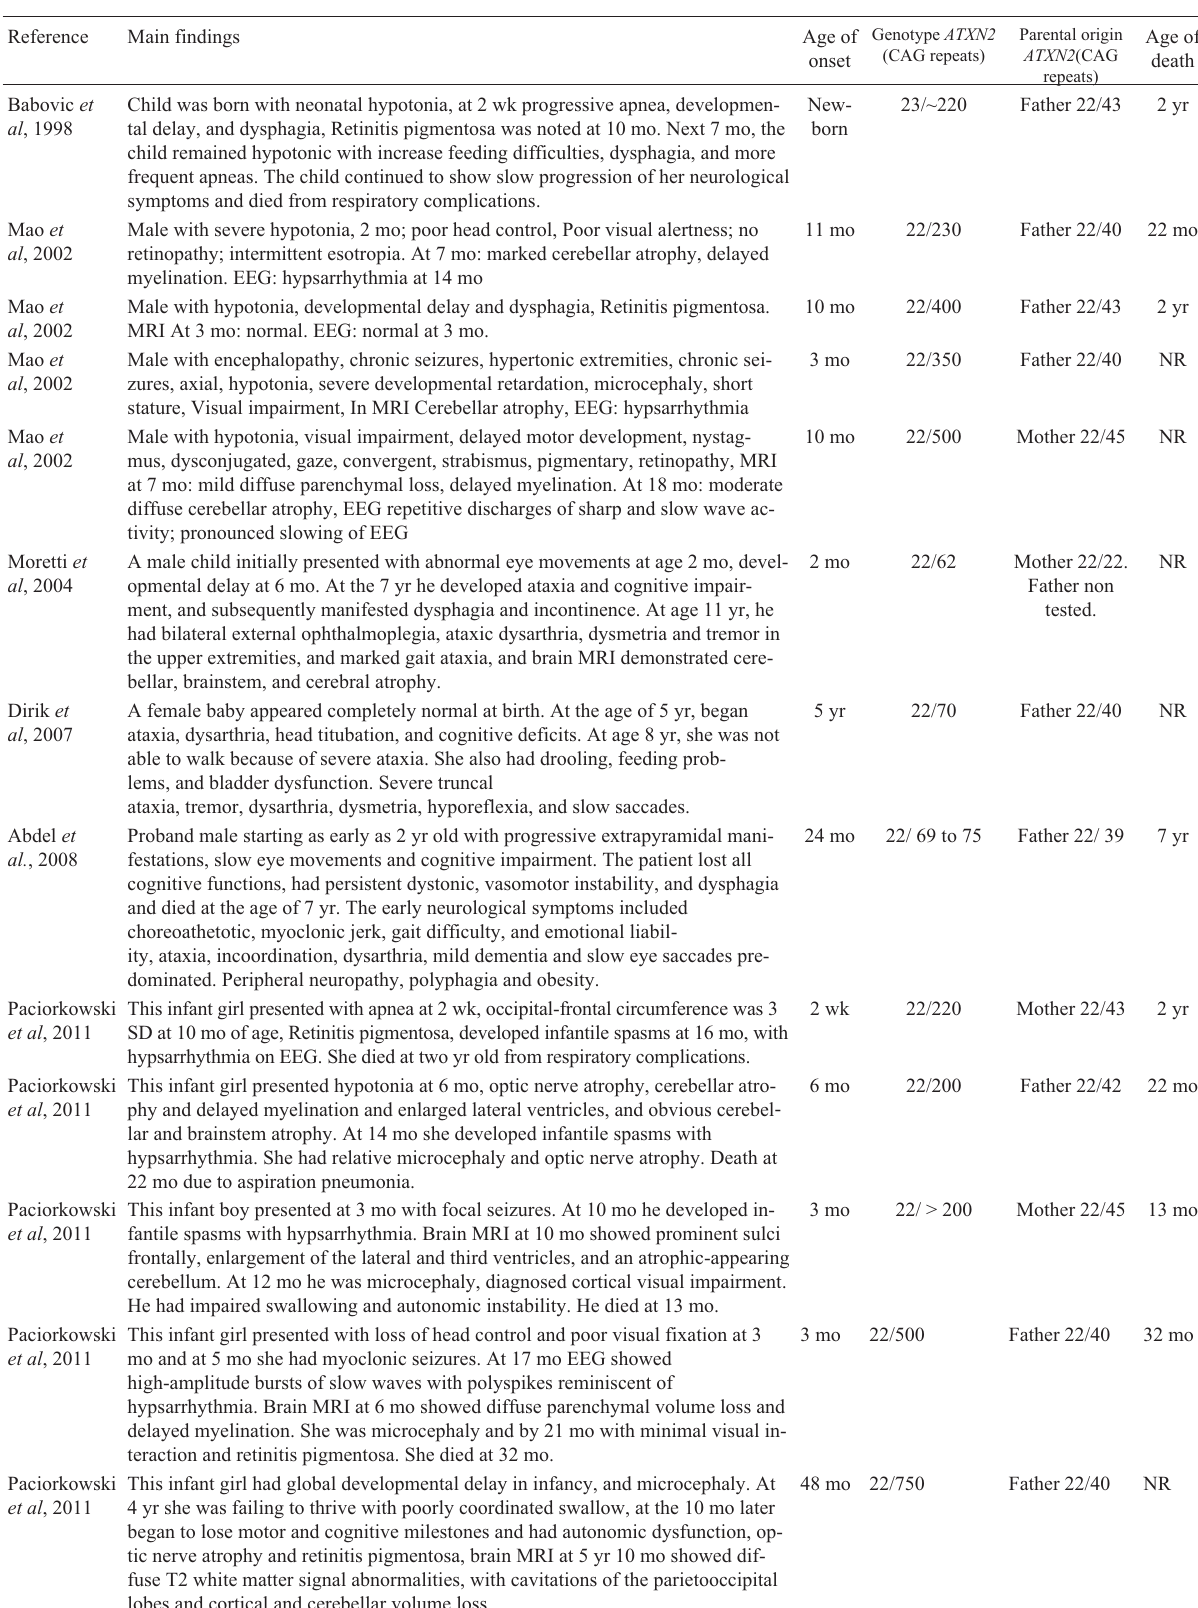
Table 1 - Previous cases review of infantile-onset